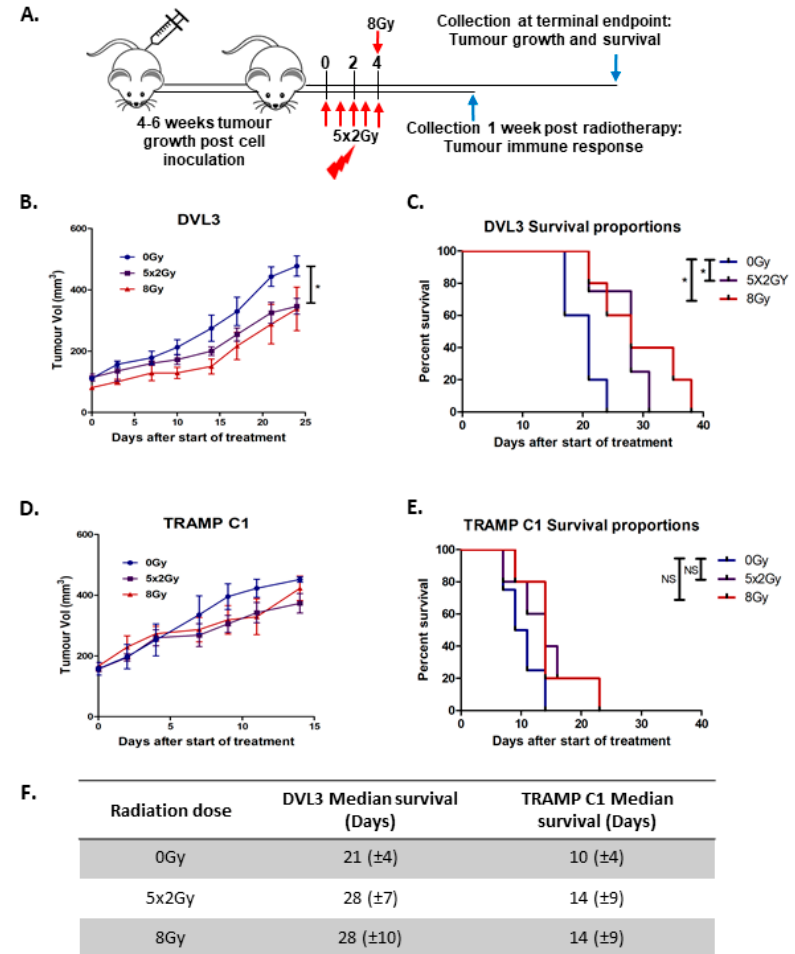
Figure 3. DVL3 tumours respond and are more sensitive to radiotherapy than the resistant TRAMP C1 model. ( A ) DVL3 or TRAMP C1 cells were engrafted into immune competent mice and allowed to